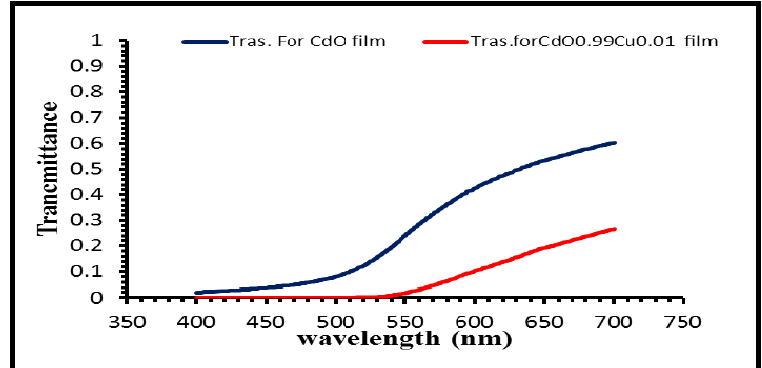
Fig. 5:Transmittance spectrum of CdO and CdO